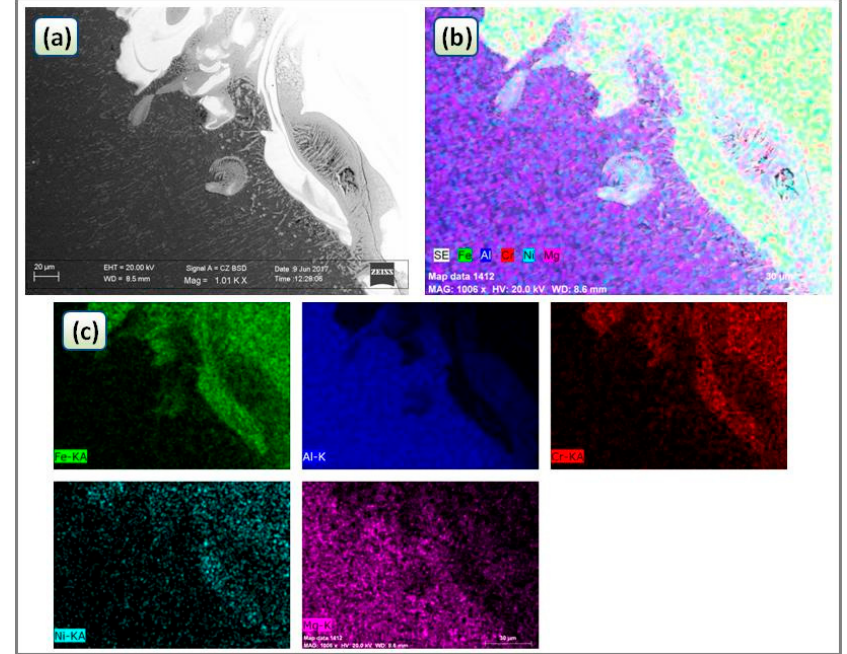
Figure 11. ( a ) SEM micrograph (Back scattered electrons) showing the IMC layer ( b ) alloy elements mapping and ( c ) maps of single elements at the joint interface.